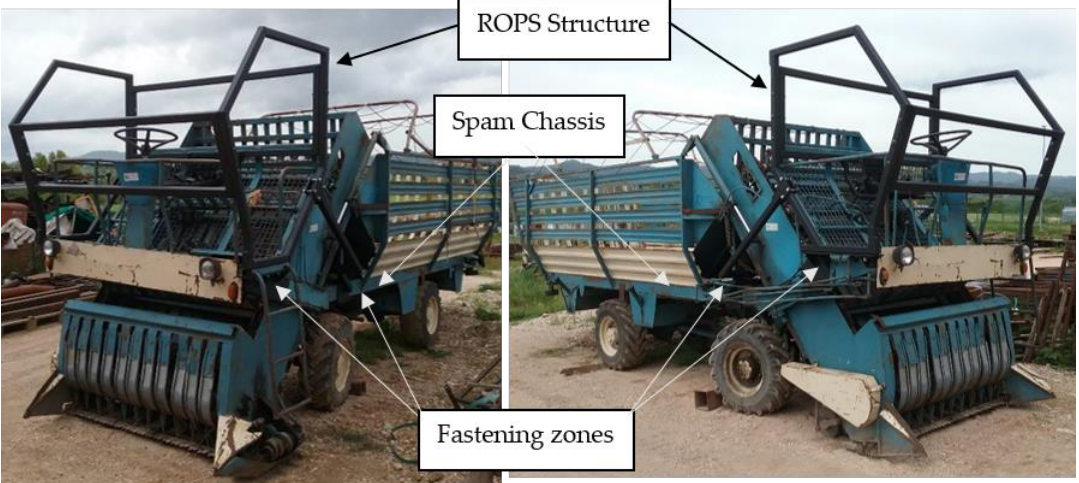
Figure 9. The self-propelled forage harvester equipped with ROPS structure.